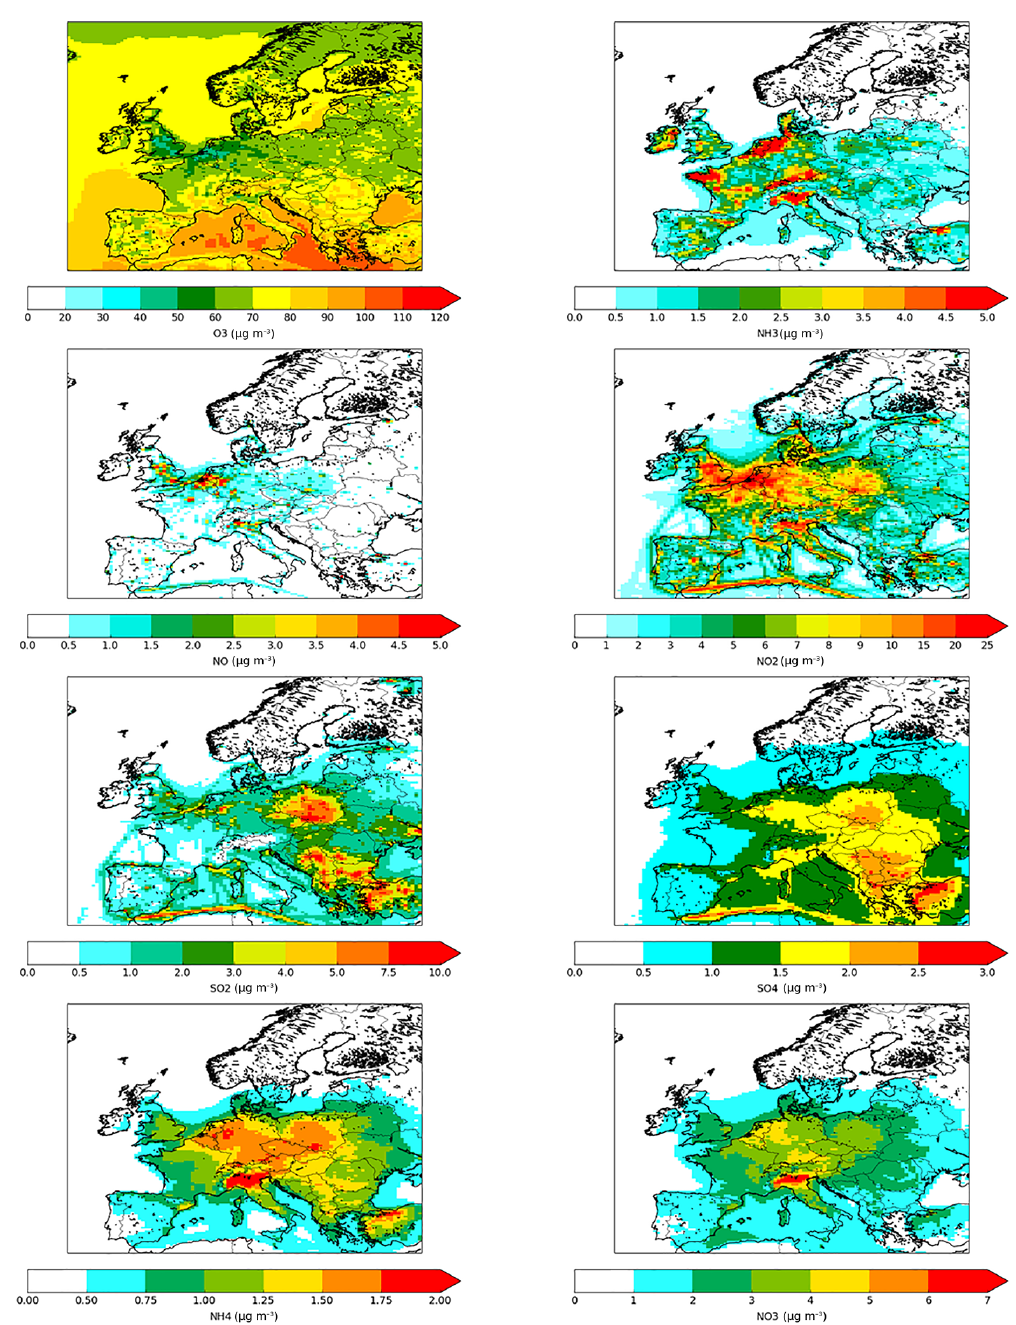
highlight the model’s special functionalities and applications, which are not all part of the open-source version. The source apportionment and particle number modelling features are not part of the open-source version of LOTOS–EUROS